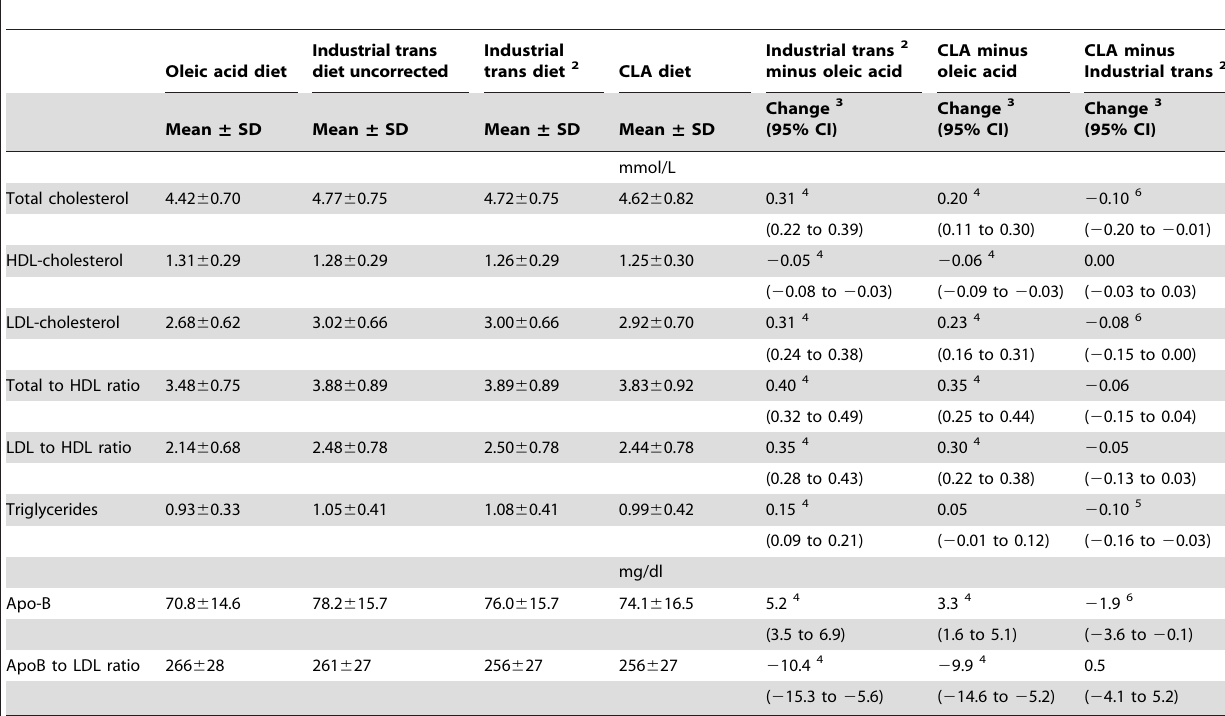
Table 4. Mean ( 6 SD) values for serum lipid, lipoprotein cholesterol and apoB levels at the end of the three dietary periods (n=61), and means (95% Confidence Intervals) for individual differences between diets.